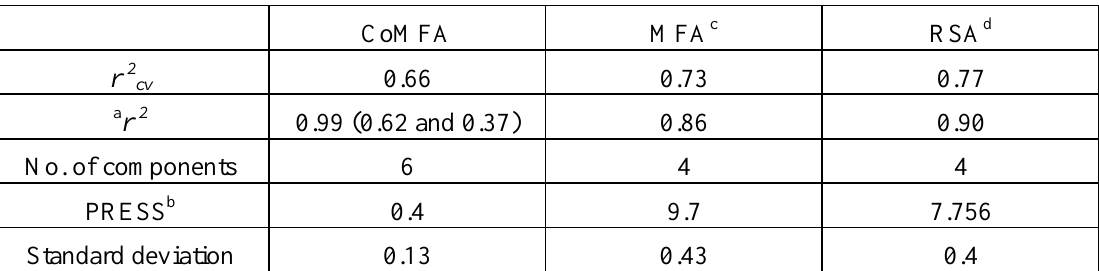
Table 3. Details of CoMFA, MSA, and RSA